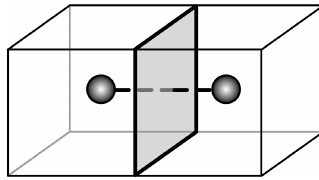
Figure 2. Two adjacent cells connected by a dual edge (dashed line) which also represents a shared face (grey); two end points of the dual edge represent two primal cells.